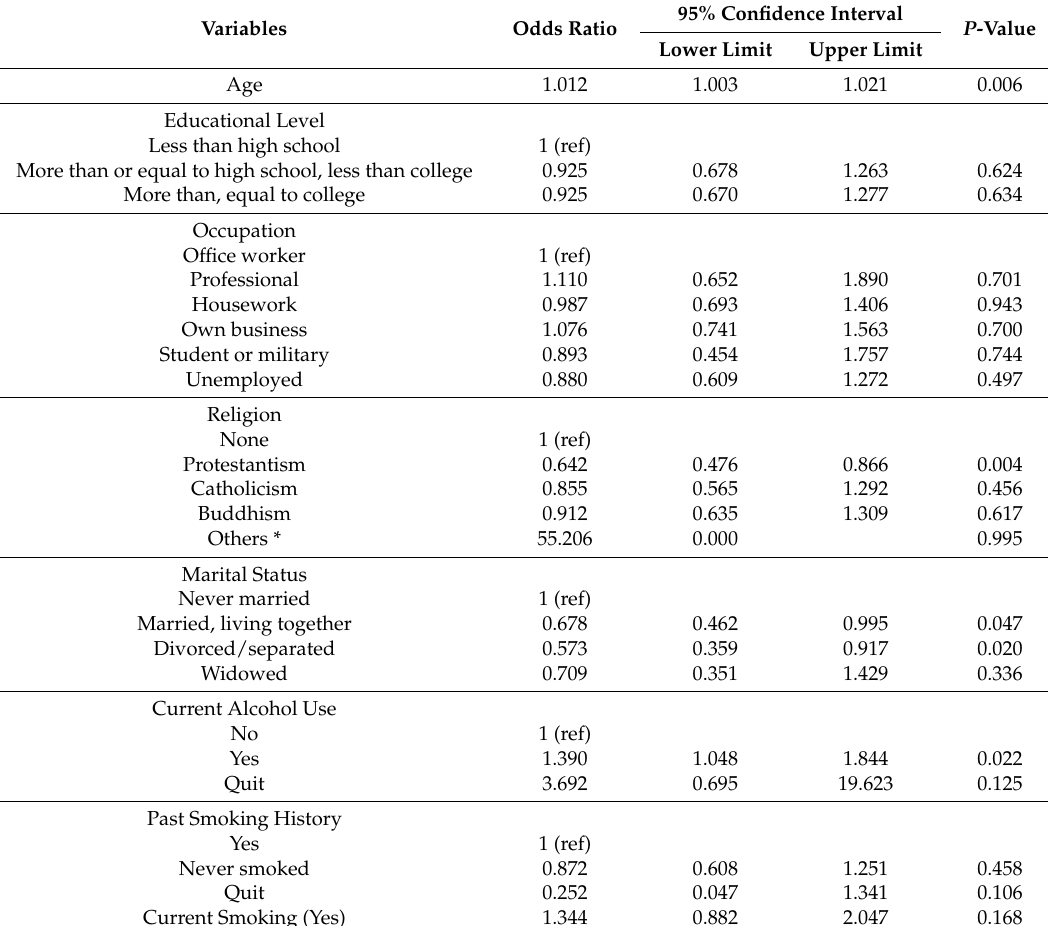
95% Confidence Interval P -Value Lower Limit Upper Limit